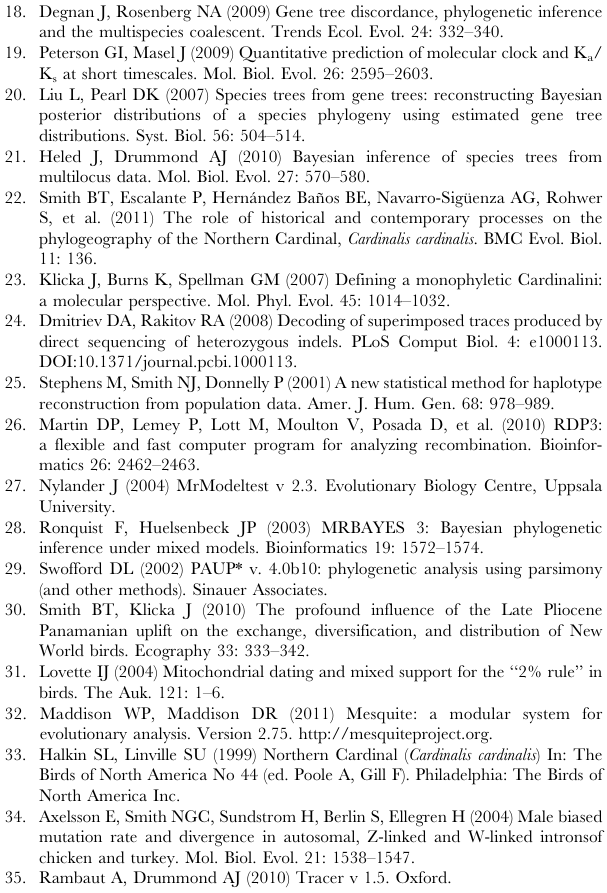
Figure S1 Consensus gene tree generated in MrBayes.